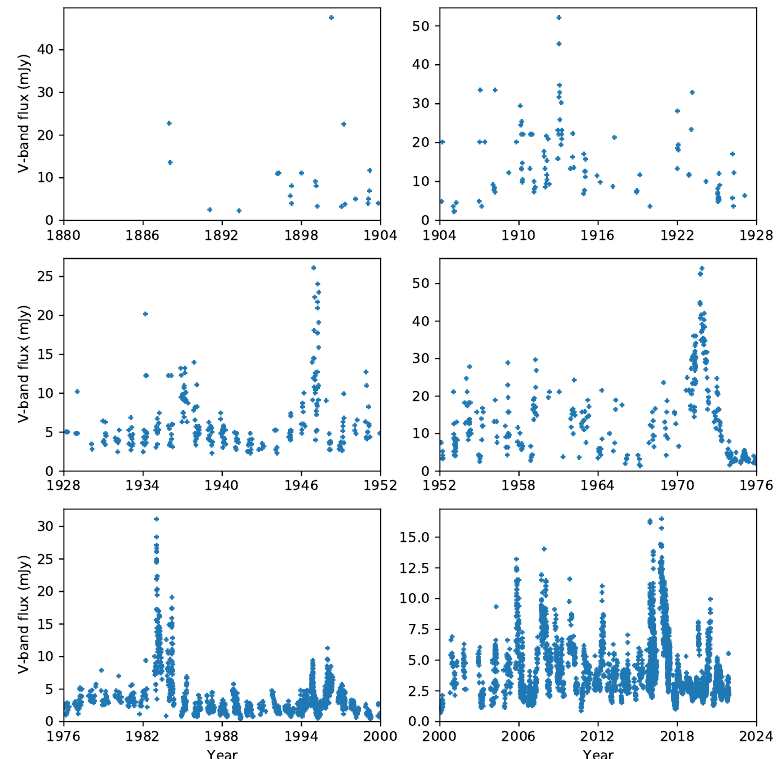
Figure 1. Optical lightcurve of OJ 287 between 1888 and 2021. The figure includes a large number of previously unpublished data points by two of the authors (R.H., S.Z.). All point have been transformed to the V-band, including data in Laine et al.